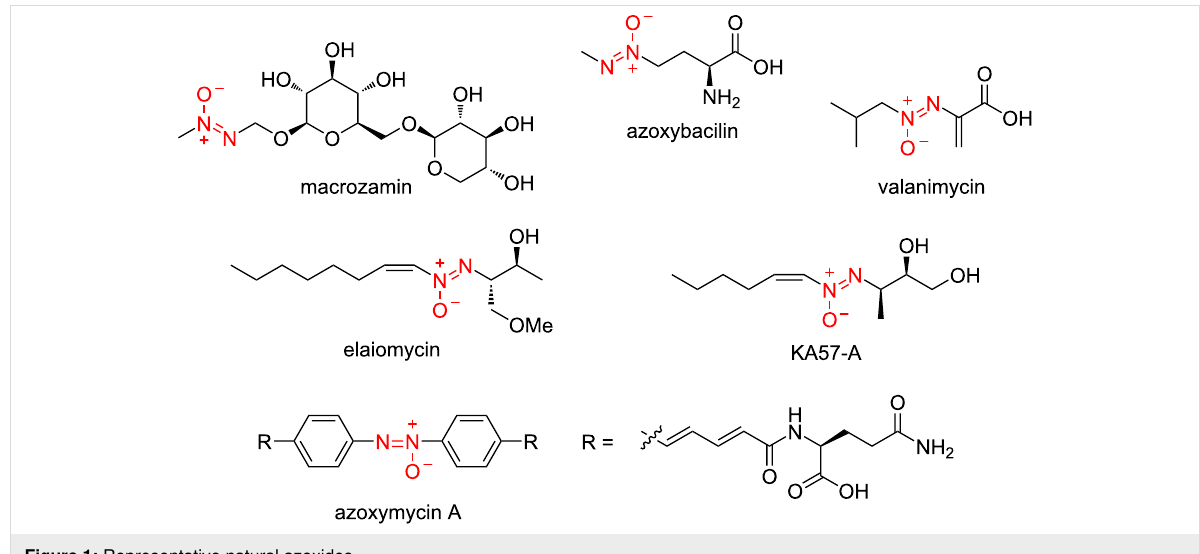
Figure 1: Representative natural